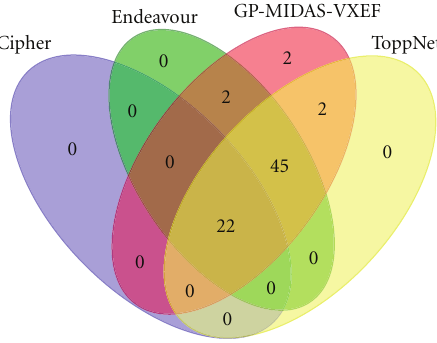
Figure 5: Venn diagram shows how the set of target genes is found amongst the di ff erent methods tested.